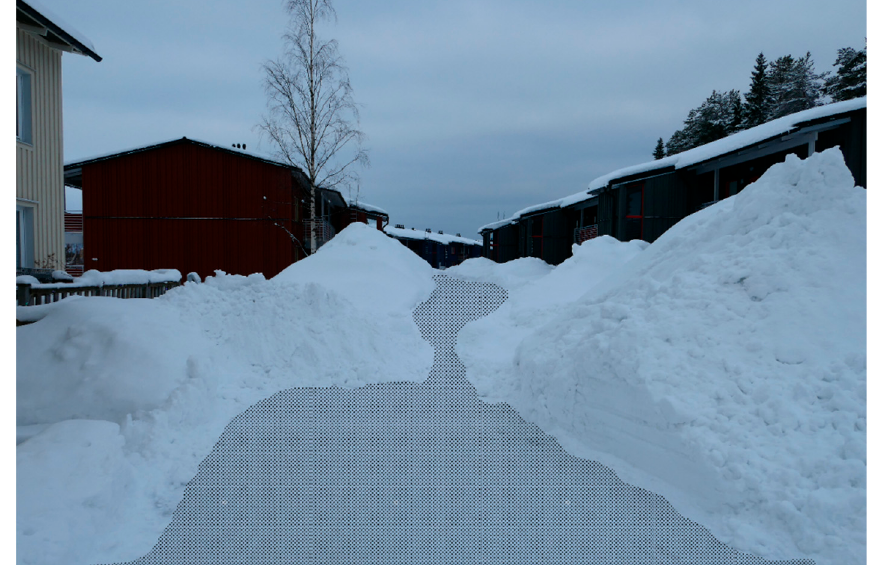
Figure 3. A residential street in Luleå in winter, with the usable area for soft-mobility indicated with the shading. These conditions can be in place for up to six months of the year.